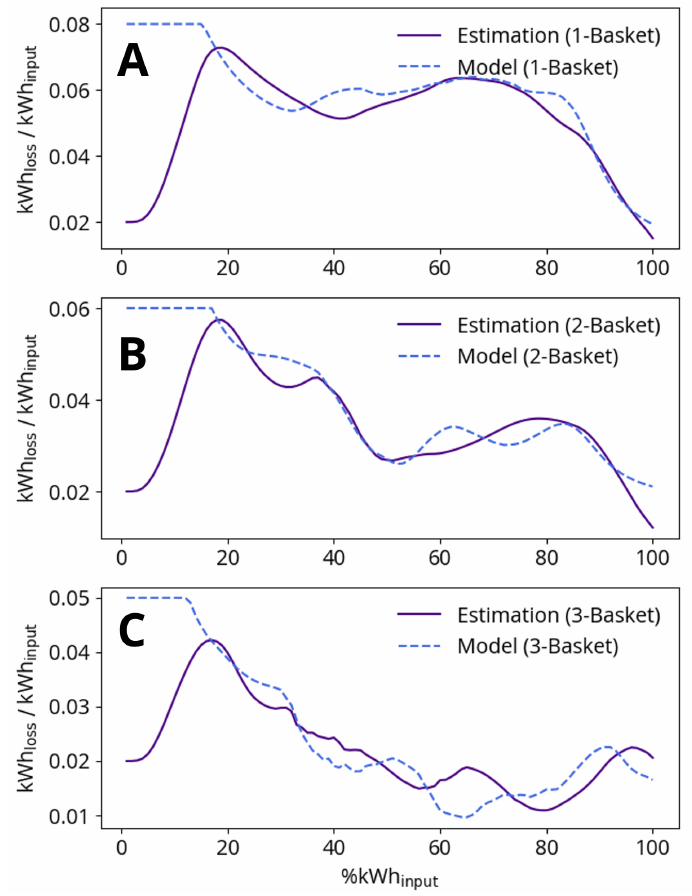
Figure 6. Comparison of arc efficiency estimation and model for ( A ) one-basket heats, ( B ) two-basket heats and ( C ) three-basket heats. The x -axis is the normalized progress of each heat as measured by the percentage of total electric energy added to the furnace. Low %kWh input -results are not meaningful as the efficiency estimation requires several samples to change from the initial guess factor of 0.02.